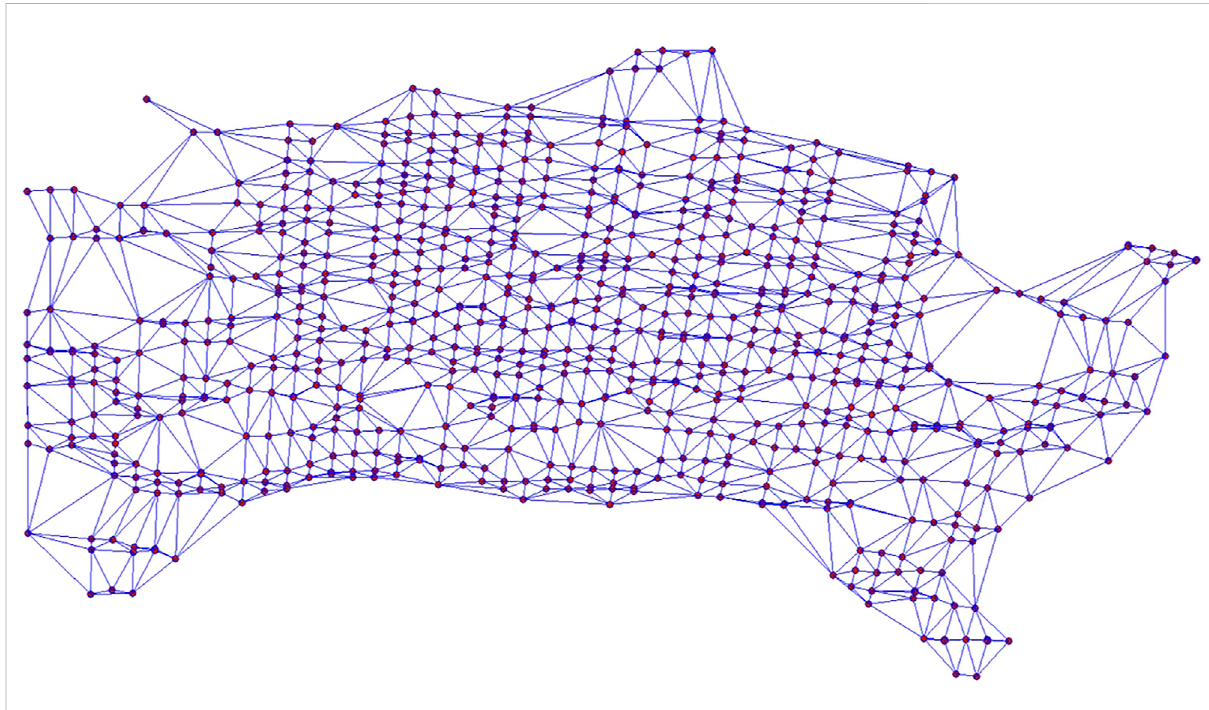
FIGURE 5 Delaunay triangulation network of PS points in GY arch dam